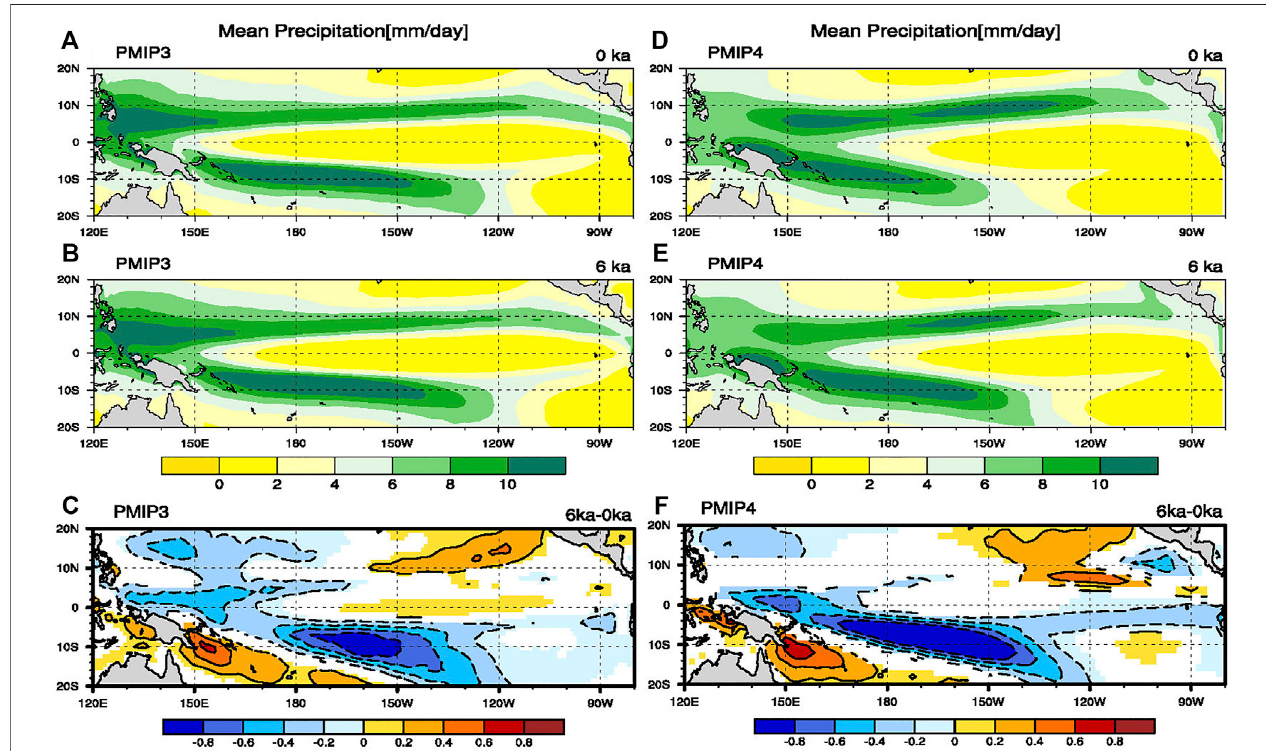
FIGURE 2 | Plots for MME of mean precipitation derived from PMIP3 (left column) and PMIP4 (right column) models. (A) and (D) are PI simulations; (B) and (E) are MHsimulations;and (C) and (F) aretheirdifferences(MHminusPI).Shadingandvectorin (C) and (F) indicatethedifferencebetweenMHandPIissigni fi cantatthe95% level by Student ’ s t